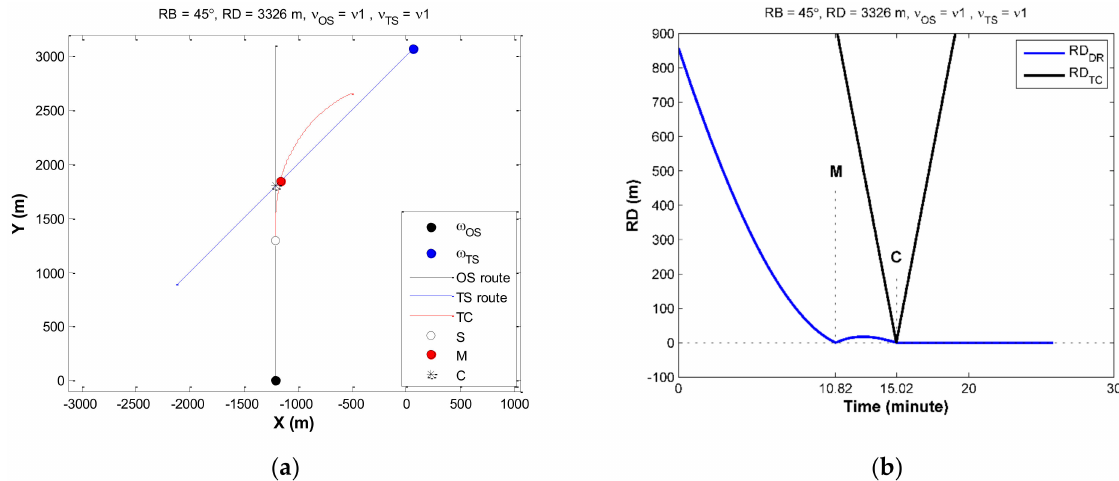
Figure 13. Estimation results for Scenario 2 (encountering angle of 45): ( a ) OS-TS encounter and collision points; ( b ) Estimation of the OS-TS relative distance and the time at collision Points C and M over time. OS-TS initial relative distance of 33,265 m, initial speed of both vessels ν 1 (5